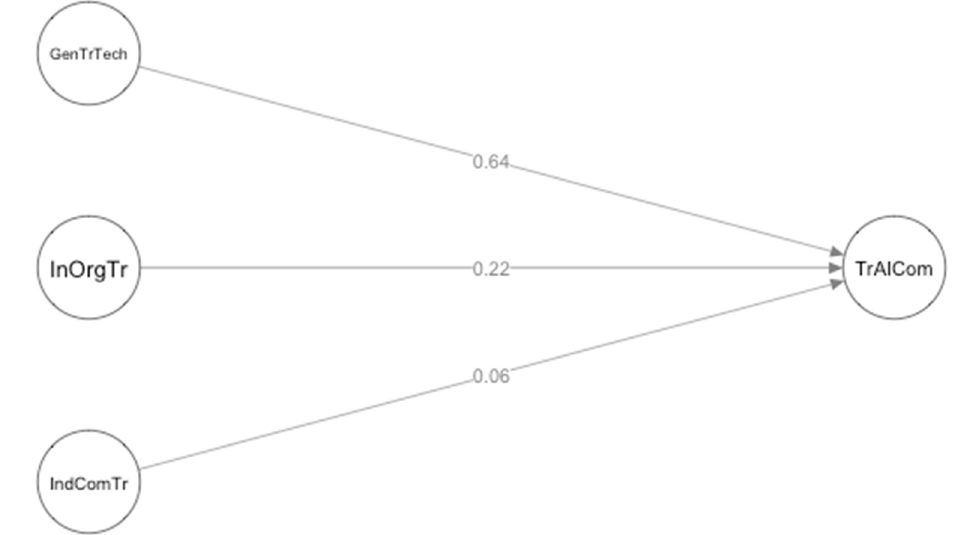
Figure 2. Structural model. Table 3. Parameter estimation of the regression model for employees’ trust in AI in the company.